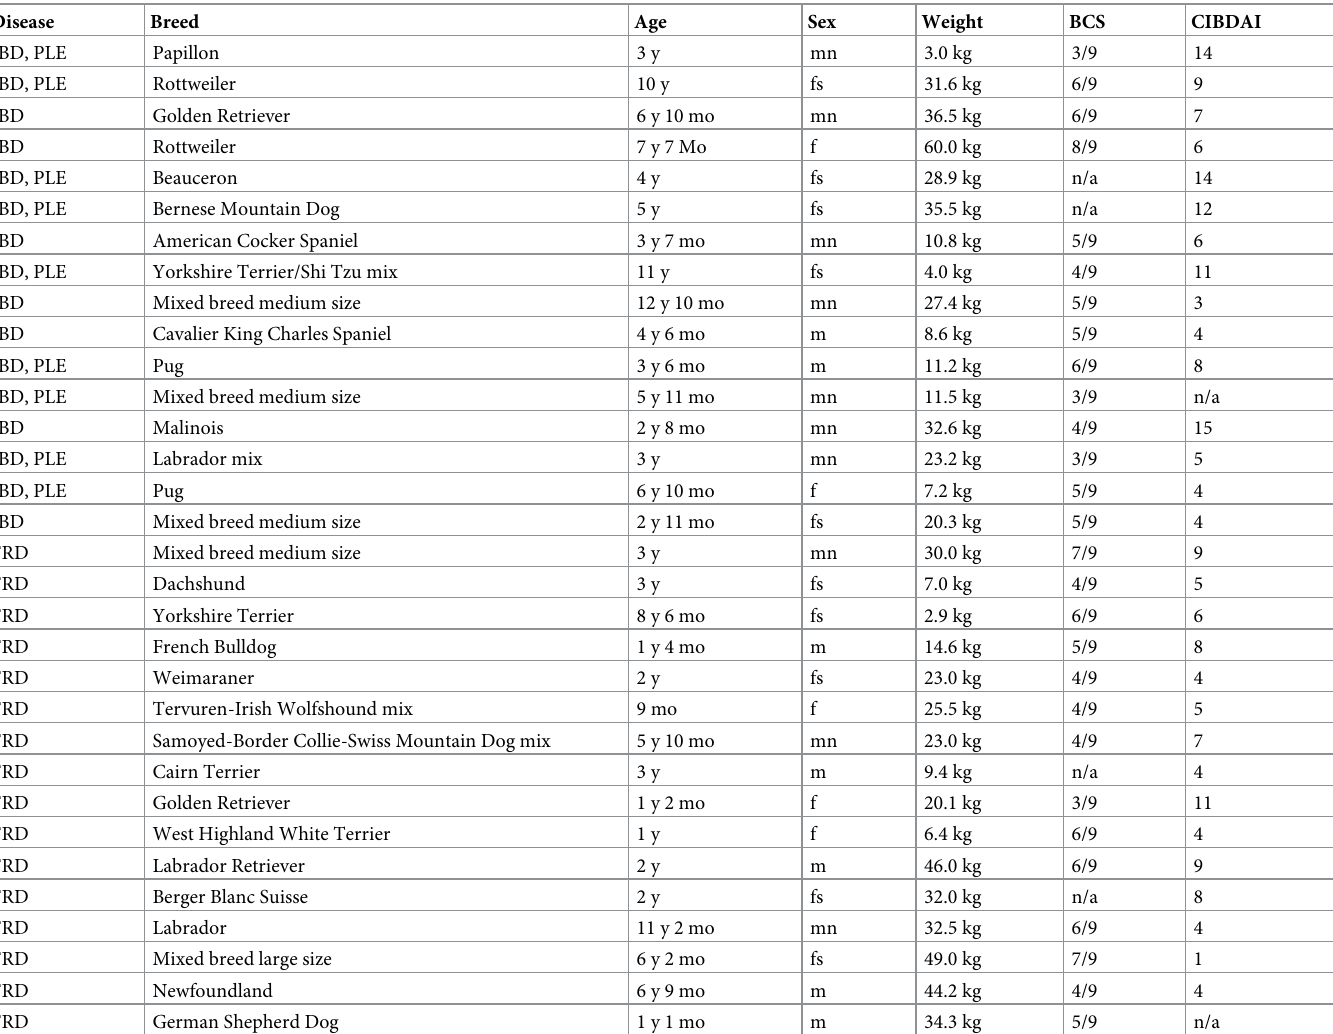
Table 1. Basic characteristics of the dogs included in the study (n = 32).